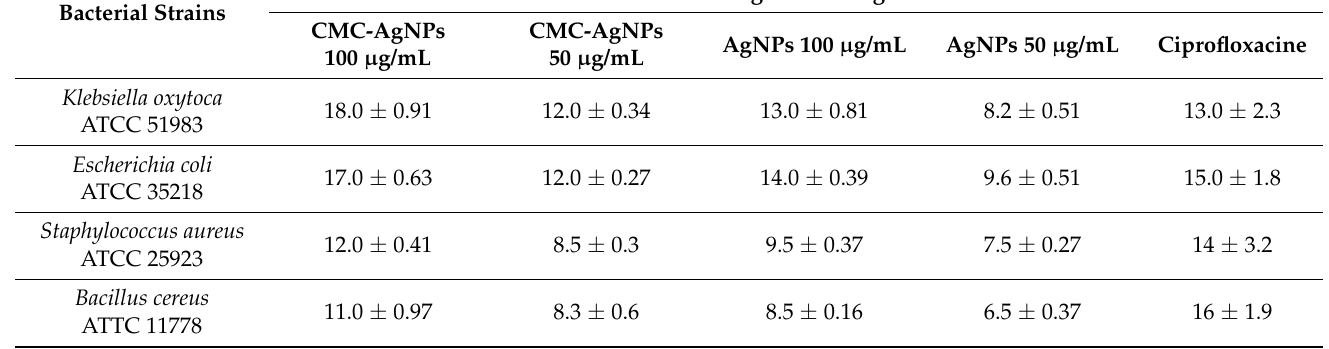
Table 1. Antimicrobial activity as indicated by a growth-inhibition zone of different concentrations of CMC-AgNPs and AgNPs against different strains of bacteria. Growth-Inhibition Zone in mm (Mean ± SD) as Caused by Different Concentrations of CMC-AgNPs and AgNPs Bacterial Strains CMC-AgNPs